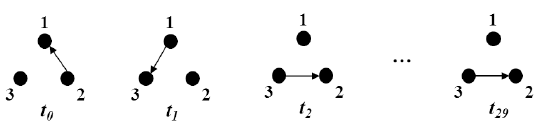
t 3 k + 1 −→ t 3 k + 2 −→ t 3 k −→ 1, 1 3, 3 2, k = 0,1, · · · , n .